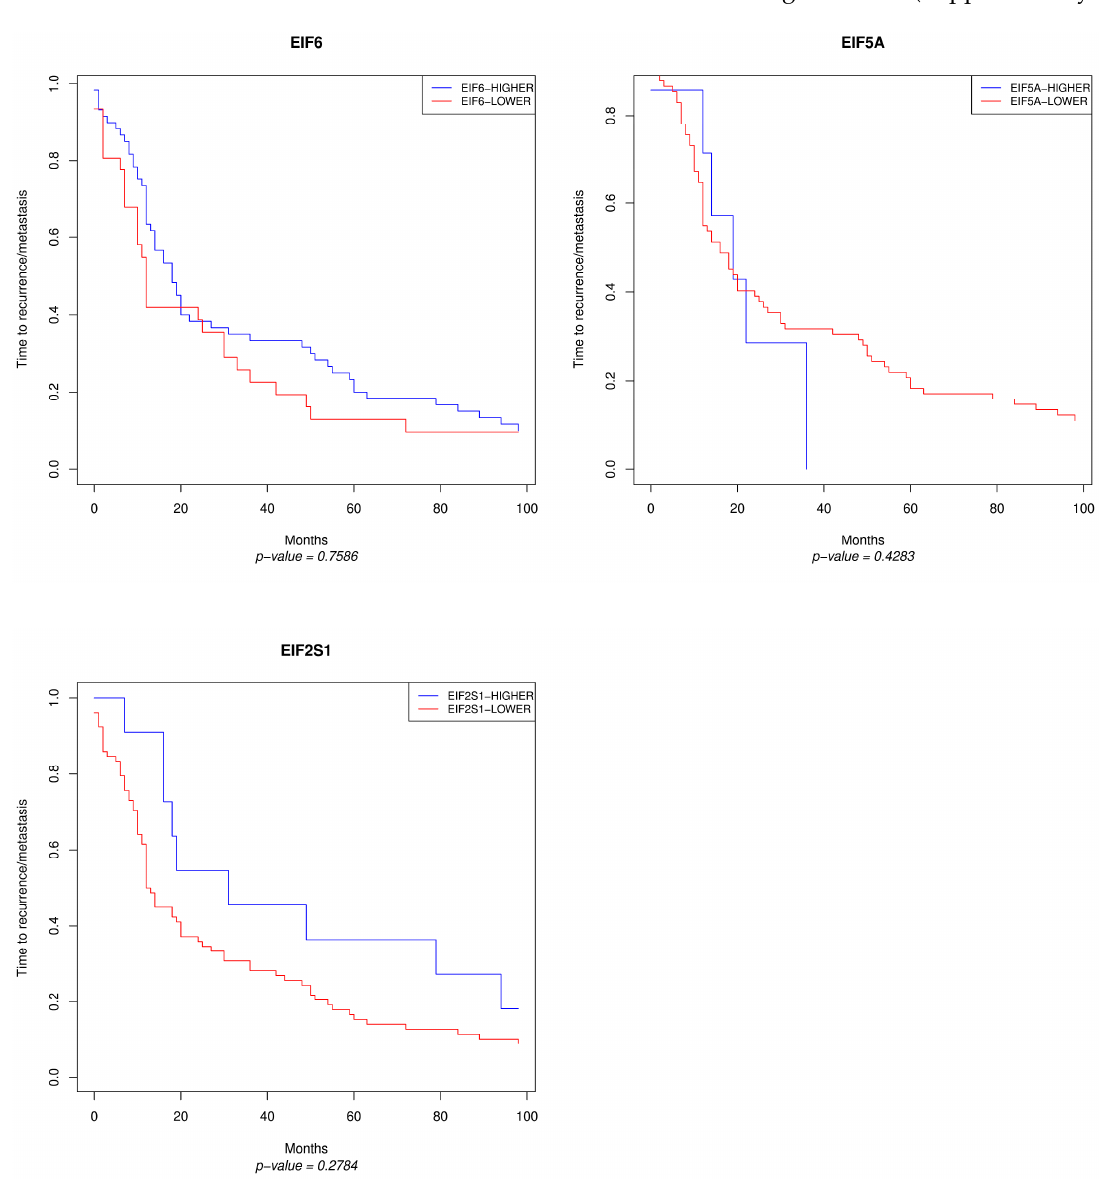
Figure 6. Kaplan–Meier diagrams of EIF2S1, EIF5A and EIF6 with scores of 1, 2, 3, 4 and 8 combined to ‘Lower’ and scores of 12 and 16 combined to ‘Higher’ based on time to recurrence/metastasis. The y-axis shows the survival probability, the x-axis the duration in months.